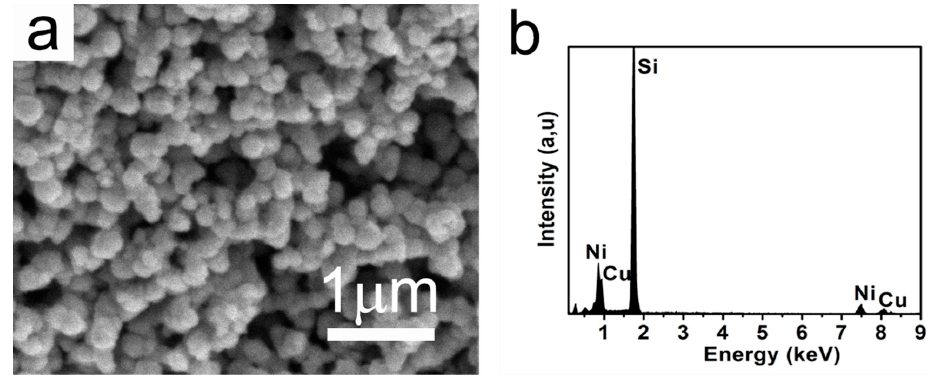
Figure 5. ( a ) SEM image and ( b ) EDX spectrum of the as-prepared CuNi NPs.